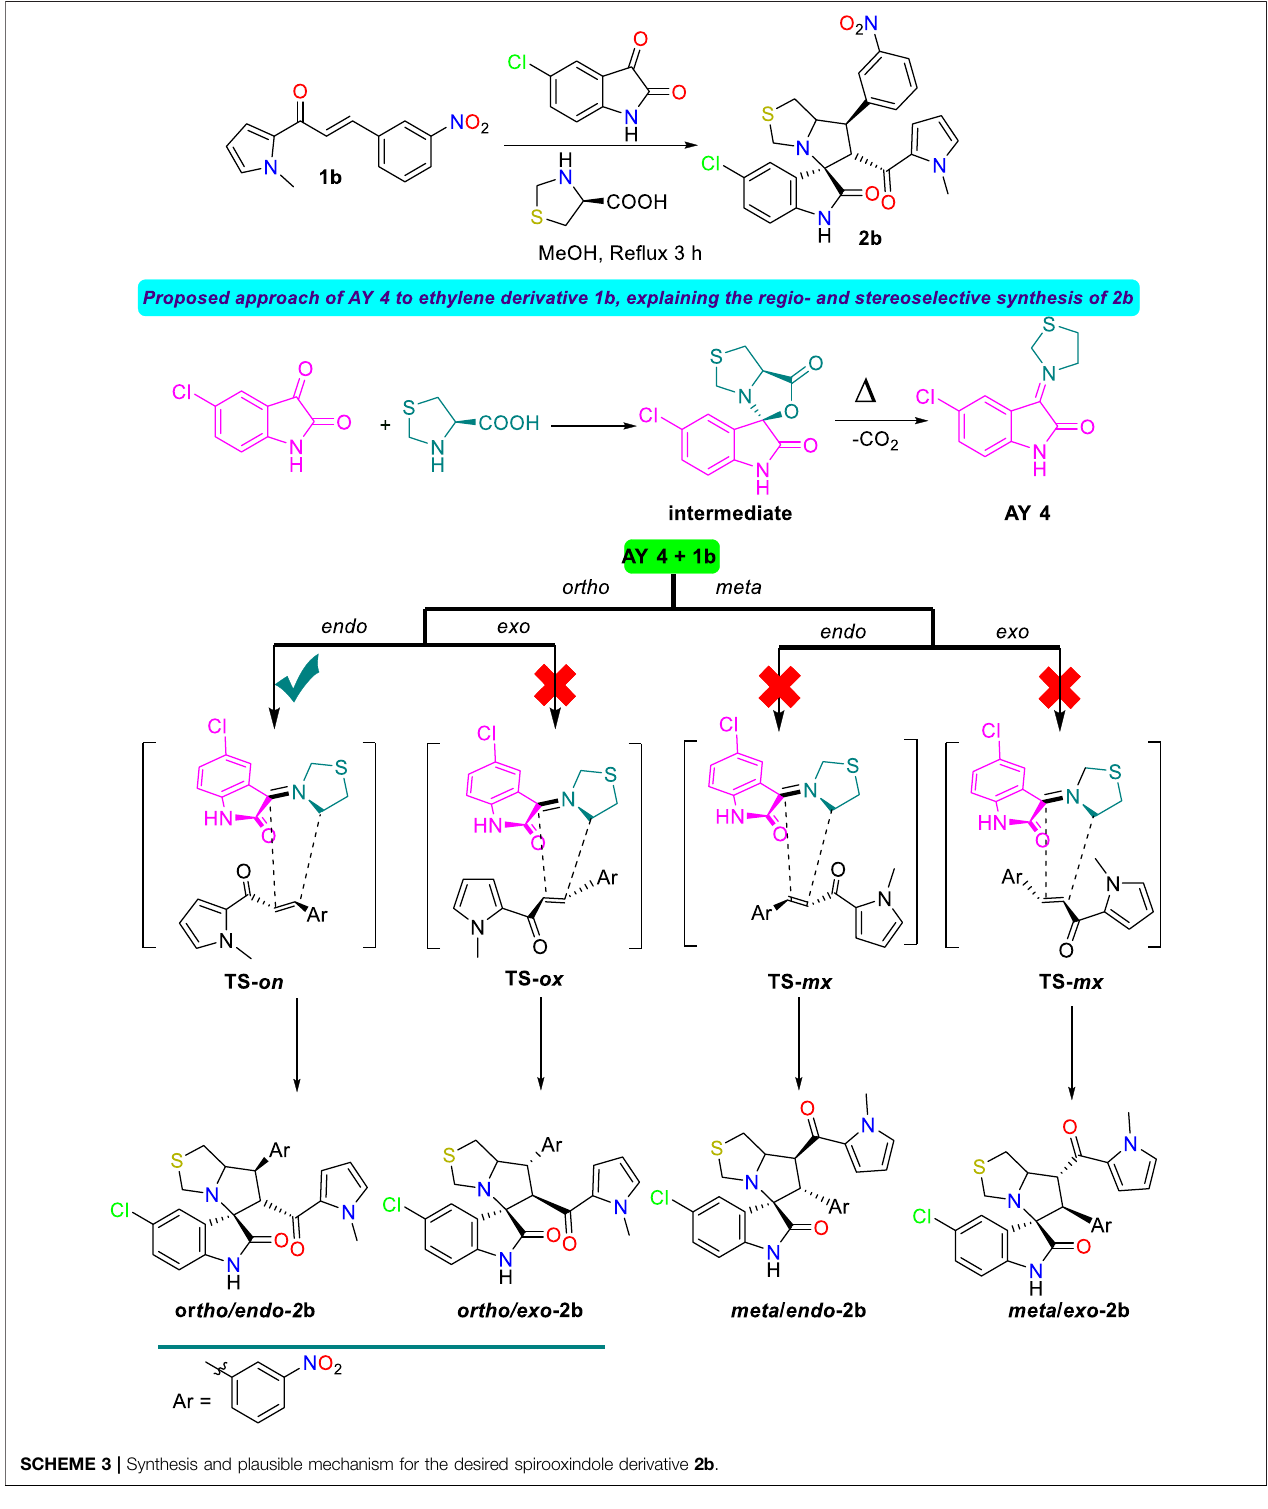
spirooxindoles via [3 + 2] cycloaddition (32CA) reaction of ole fi n-based N -methyl pyrrole with the substituted isatin, and the secondary amines Scheme 1 . Recent advances made in the